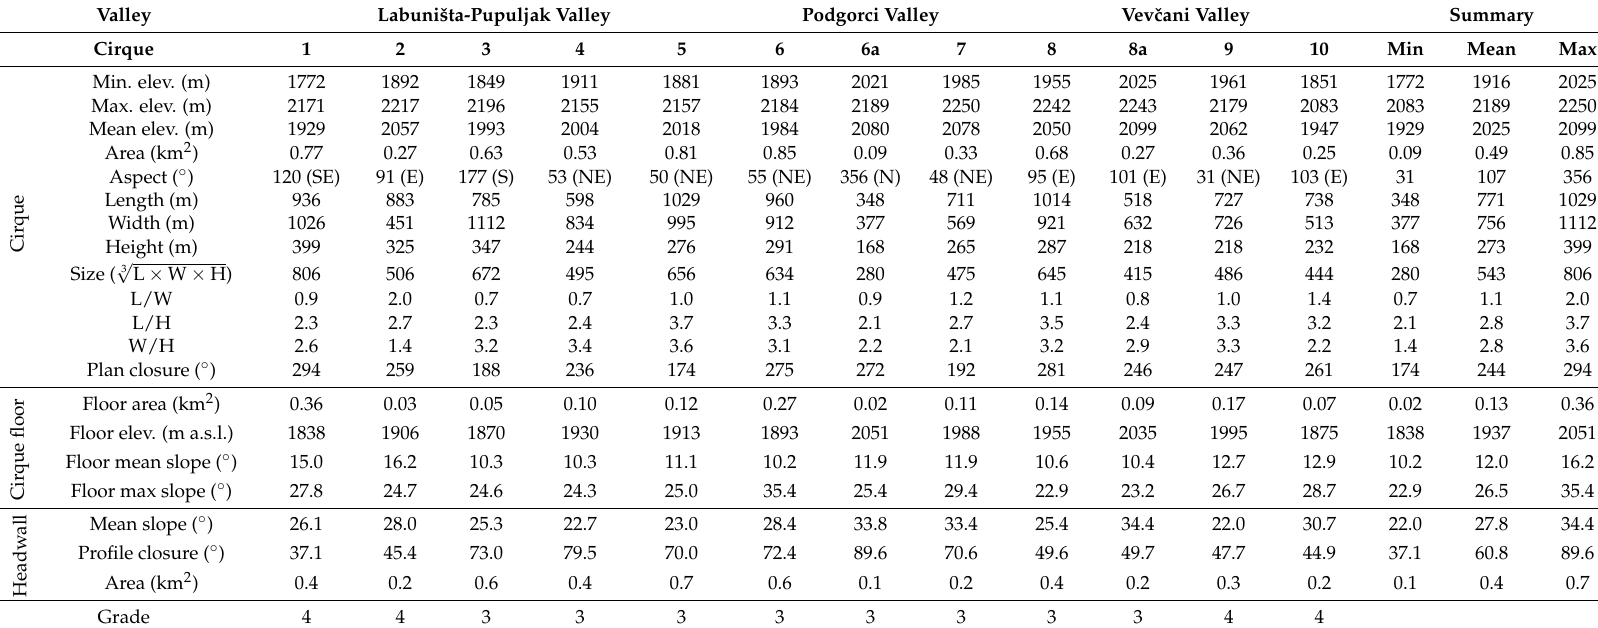
Table 1. General morphometric characteristics of the glacial cirques. Grade system according to [41], with grade 3 representing a “definite” cirque and grade 4 a “poor”